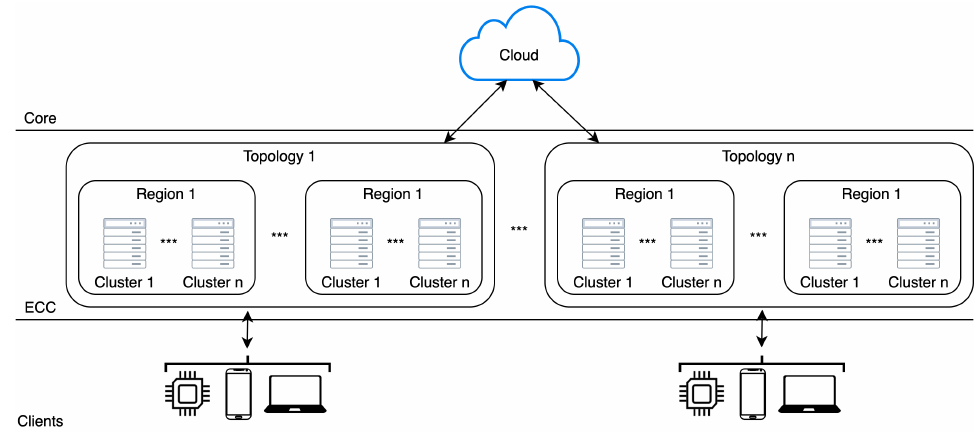
Figure 1. Micro clouds high level architecture model.